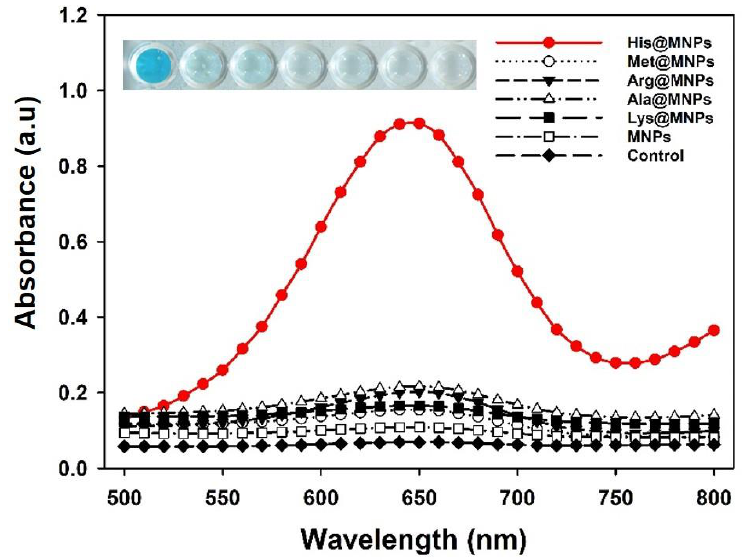
Figure 2. Investigation for the peroxidase-like activities of various amino acids coated MNPs and pristine MNPs. In the real image, the order is corresponding to the order of graph from top to bottom. To further understand the affinity between His@MNPs and substrates (TMB and